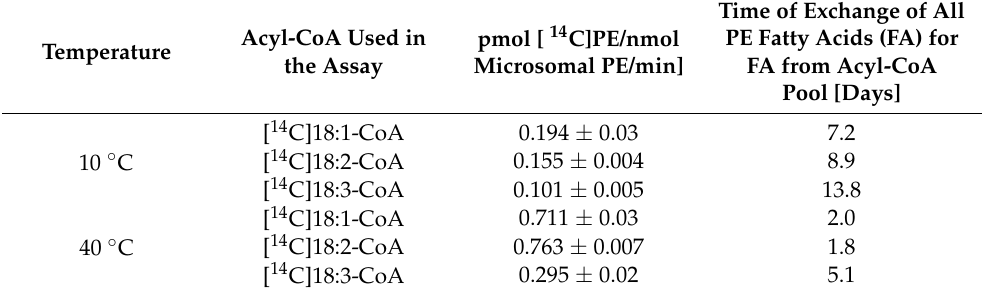
Table 1. Incorporation rate of [ 14 C]acyl groups from [ 14 C]acyl-CoA into PE of microsomal fractions of Camelina sativa in vivo leaves and estimated time of complete exchange of acyl groups of PE for fatty acids from acyl-CoA pool. Mean values and SD are presented (data from at least three independent assays).